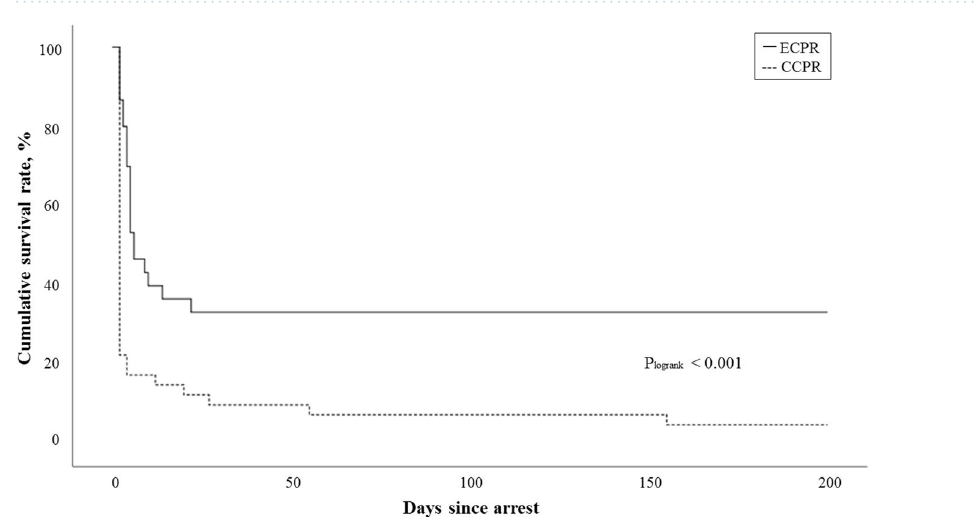
Figure 2. Good neurologic outcomes in patients receiving CCPR and ECPR. CCPR conventional cardiopulmonary resuscitation, ECPR extracorporeal cardiopulmonary resuscitation.